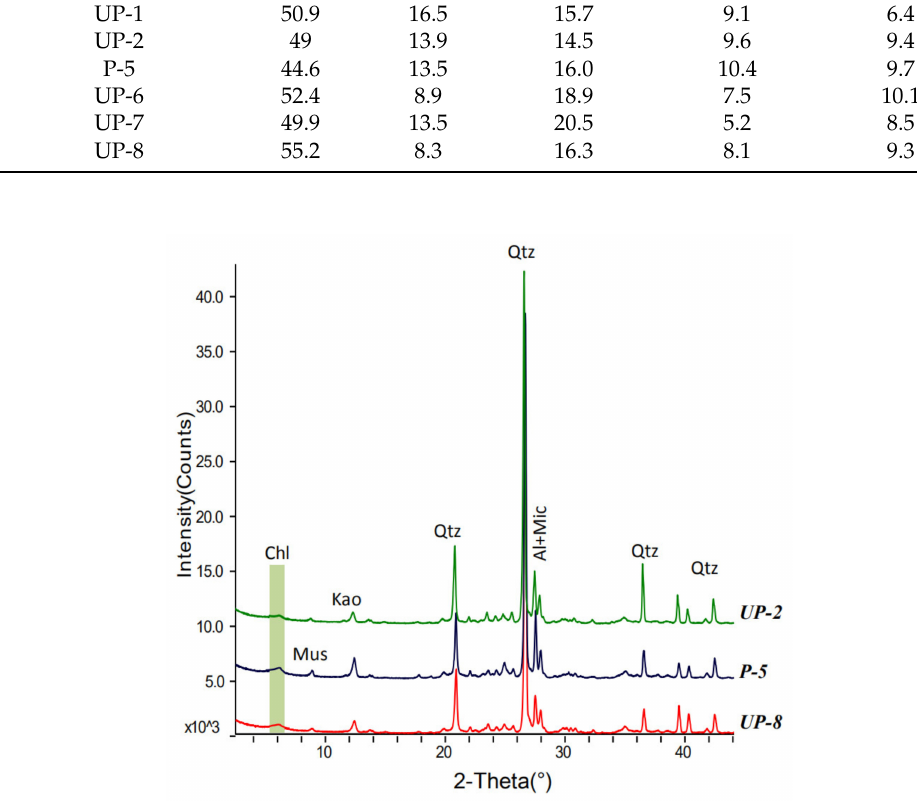
Figure 3. XRD patterns for typical pore-plugged (P-) sandstone, and the unplugged (UP-) samples above and below the ore horizon showing their similar mineralogical compositions, d values in angstrom. Abbreviations Qtz, Kao, Cha, Ms, Mic, Alb, and Fds indicate quartz, kaolinite, chamosite, muscovite, microcline, albite, and feldspar,